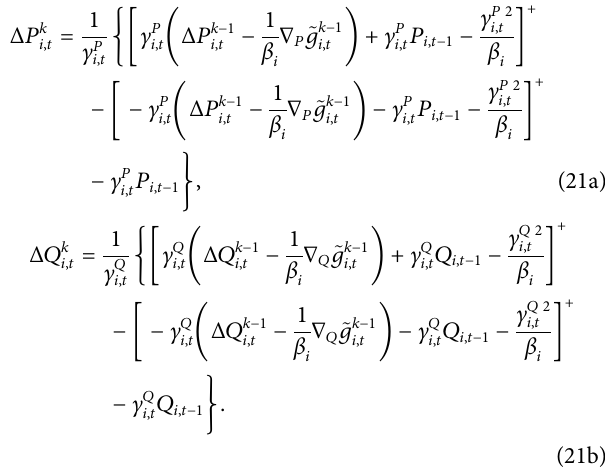
in Figure 2A . Generally,